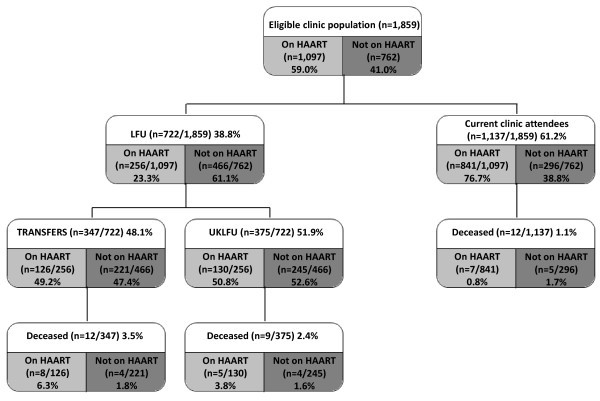
Loss to follow-up among 1859 clinic patients LFU defined as not seen for ≥ 1 year at the King's College Hospital HIV clinic (up to 31st December 2006). Transfers defined as LFU patients who subsequently have been seen elsewhere in the UK. UKLFU defined as LFU patients not seen at any treatment site in the UK for ≥ 1 year. CCAs defined as patients who remained under King's College Hospitals clinic follow-up as of 31st December 2006.